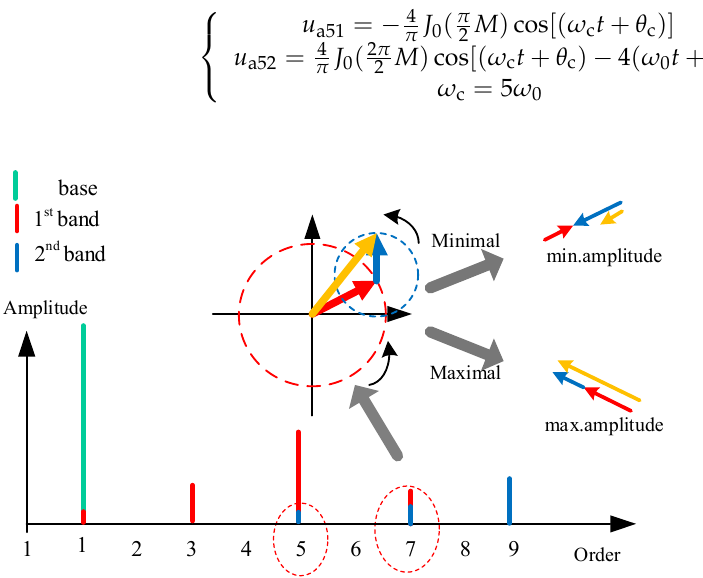
Figure 4. Frequency spectrum for two-level SPWM output when C r = 5.